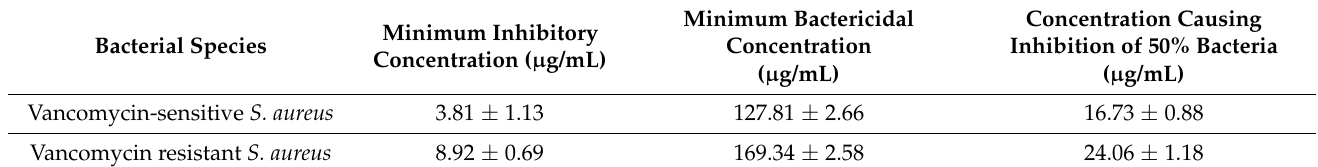
Figure 24. Minimum inhibitory concentration of vancomycin, Van ‐ NMOFs, NMOFs and CS ‐ Van ‐ NMOFs. Graph ( A ) shows when they were tested against sensitive S. aureus . Graph ( B ) shows when they were tested against resistant S. aureus . Reproduced with permission from [186] . Table 3. Minimum inhibitory concentration, minimum bactericidal concentration, and concentration causing inhibition of 50% bacteria of CS ‐ Van ‐ NMOFs when they were tested against sensitive S. aureus and resistant S. aureus [186].